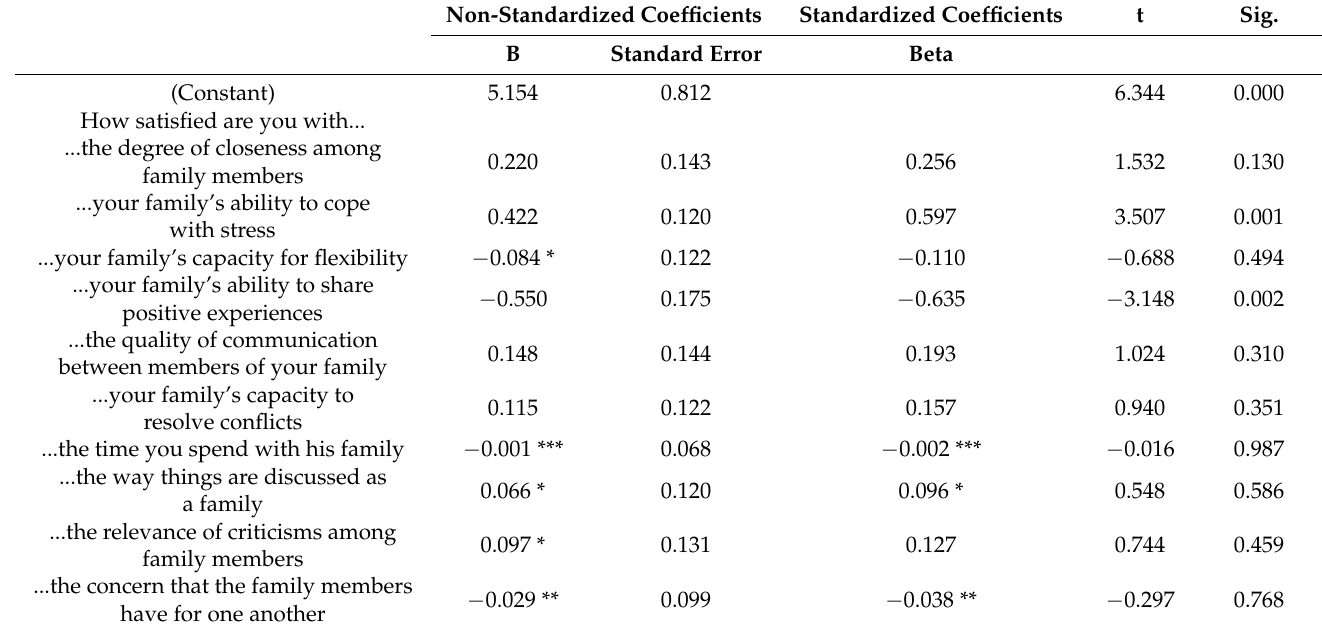
Table 8. Regression coefficients Model 2 (Family Satisfaction